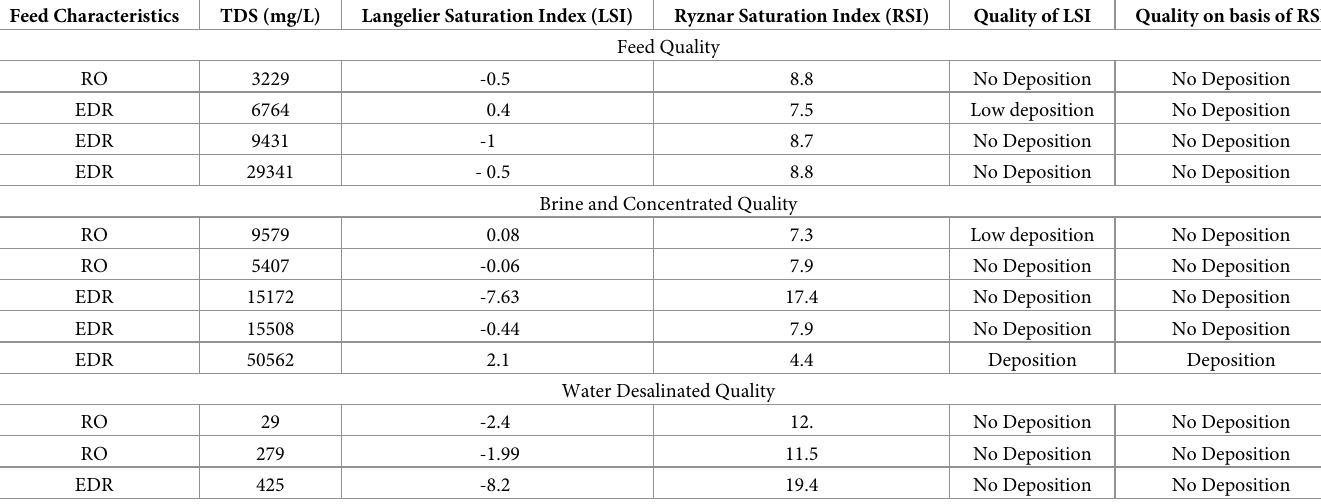
Table 5. The stability index of the feed brine and the permeate of the Eshtehard desalination plant and in the bench-scale EDR. Feed